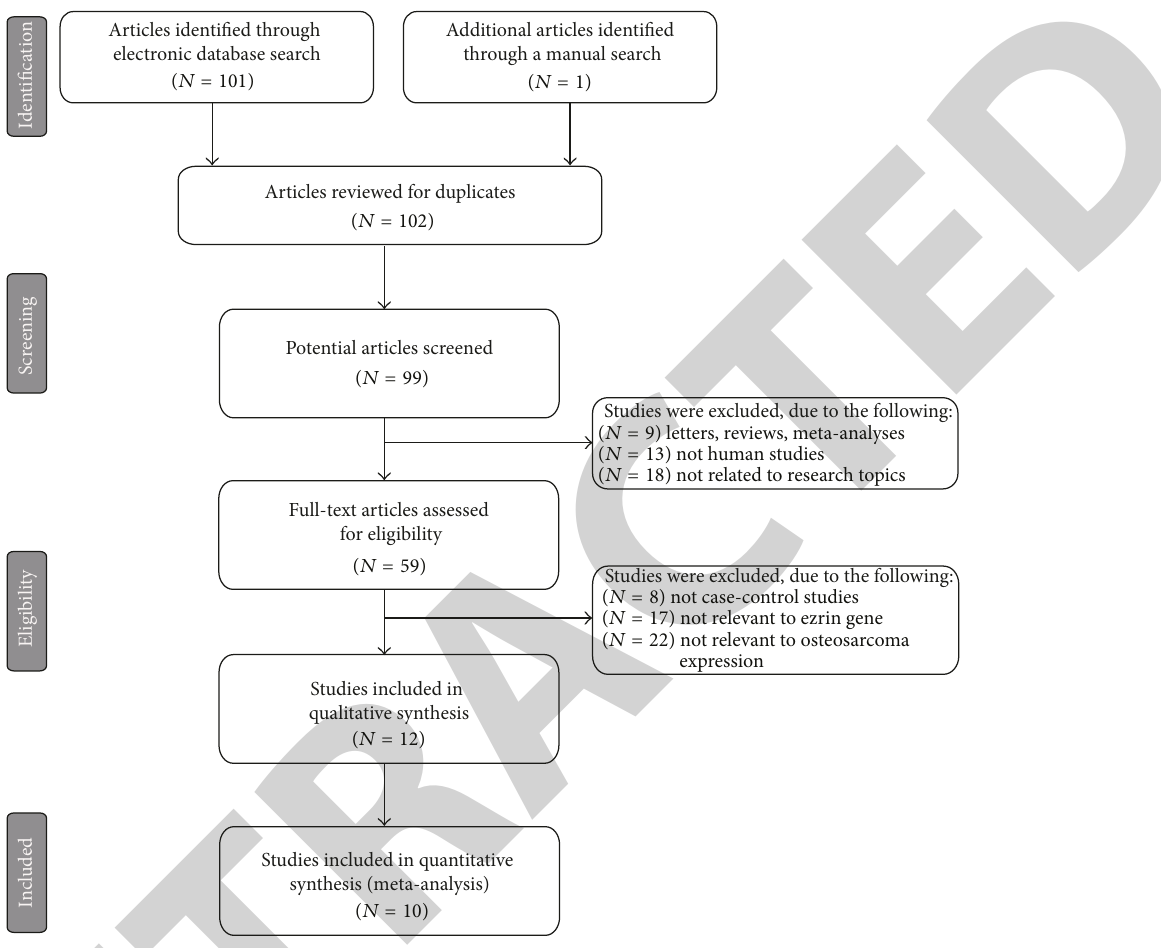
Figure 1: Flow chart shows study selection procedure. Ten cohort studies were included in this meta-analysis.